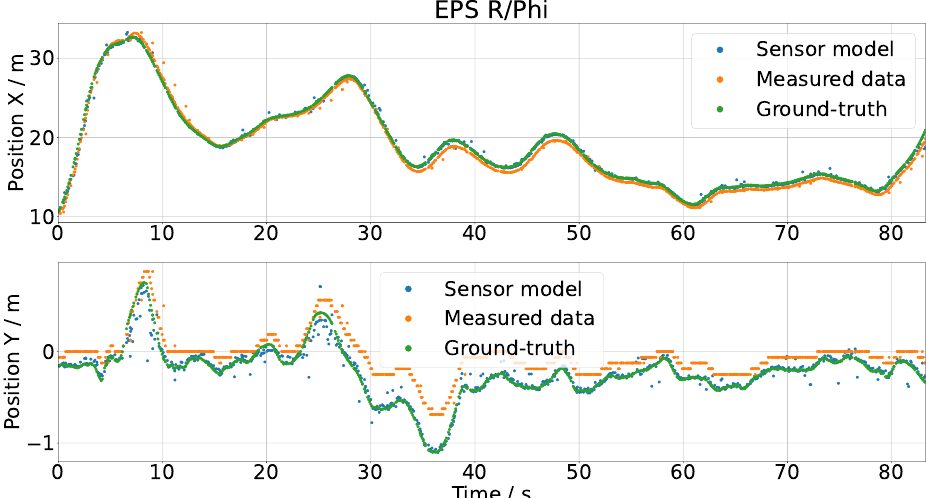
Figure 22. Results of the inertia model by using the test data as the input.